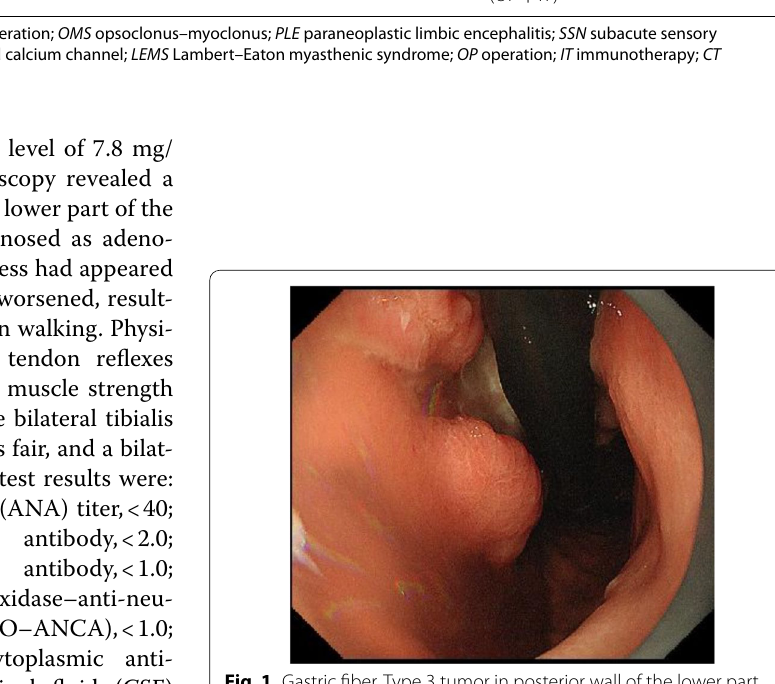
Fig. 1 Gastric fiber. Type 3 tumor in posterior wall of the lower part of the